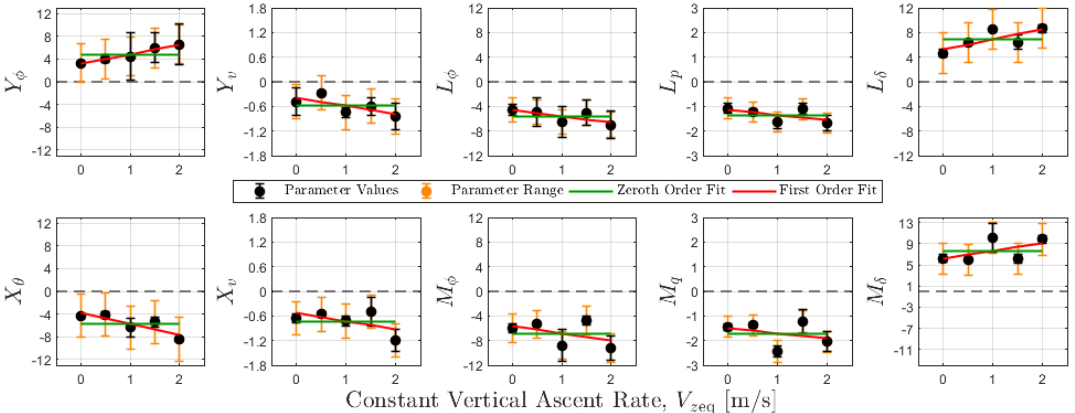
Figure 5. Roll and pitch model parameter estimates corresponding to vertical constant ascent rates V z eq = { 0.0,0.5,1.0,1.5,2.0 }